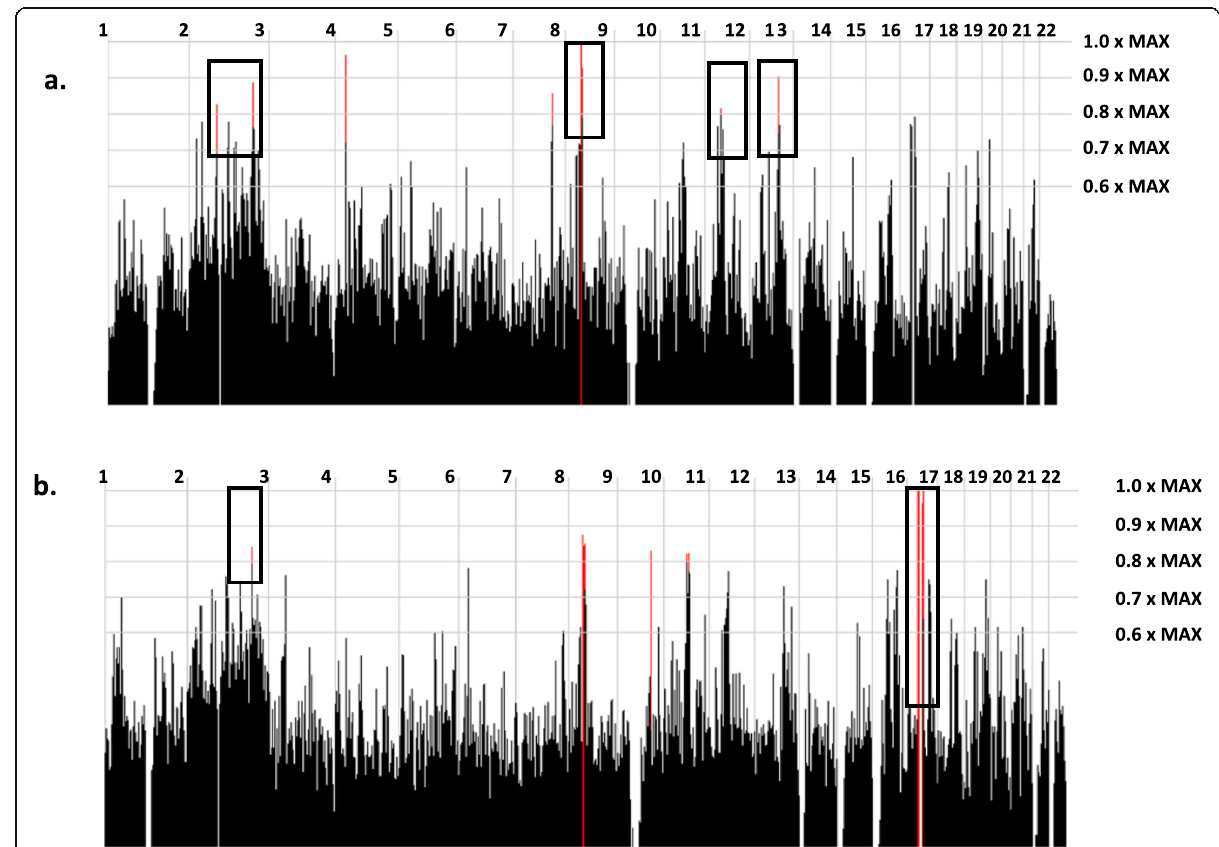
Fig. 1 Risk homozygous haplotype region peaks for autism specific enclosed in solid rectangles respectively for category